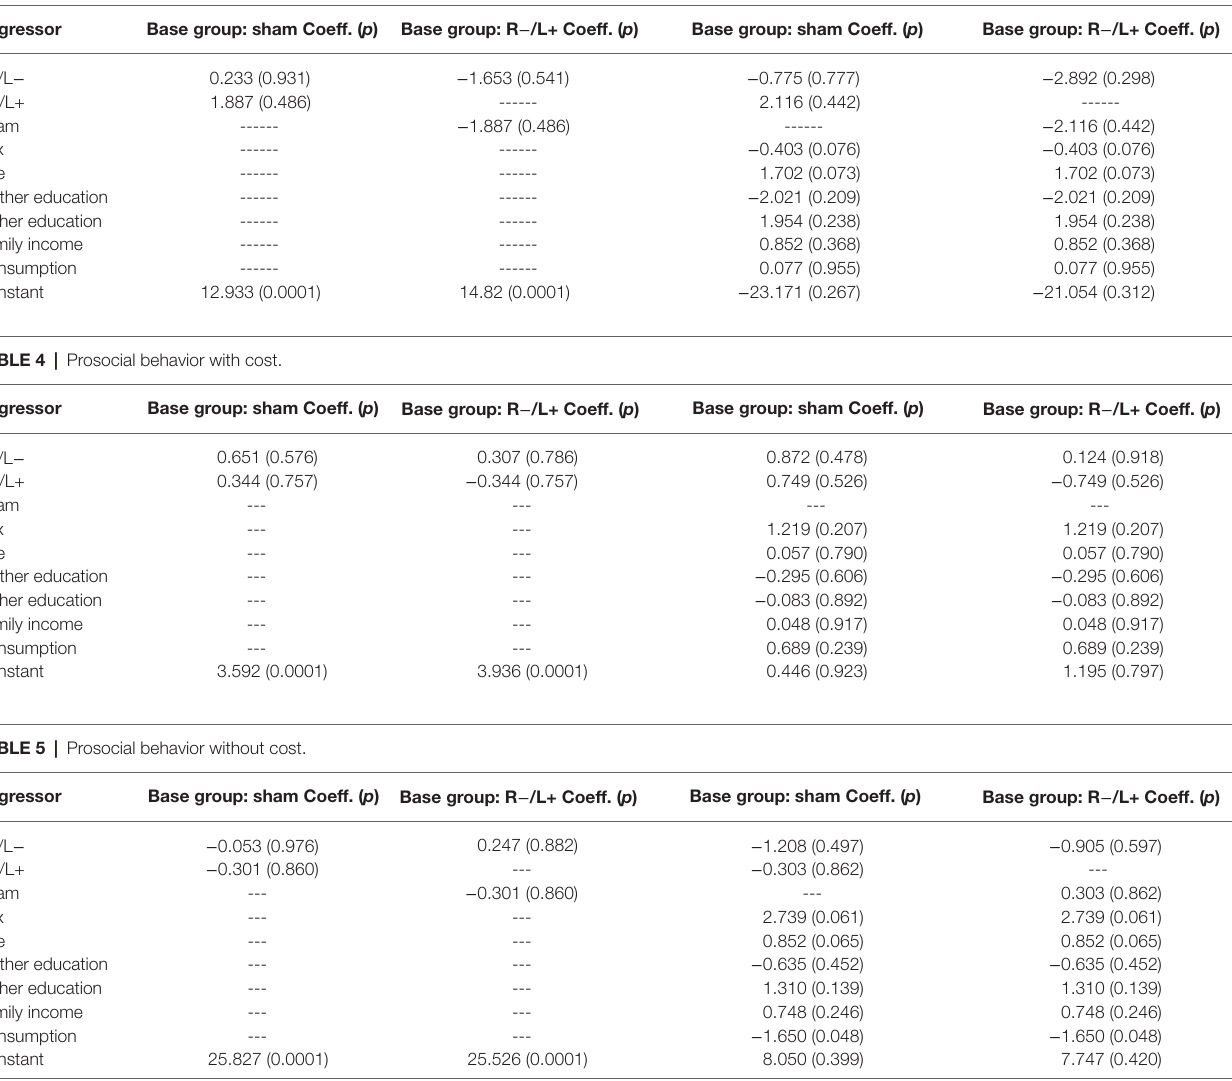
TABLE 3 | Antisocial behavior without cost.